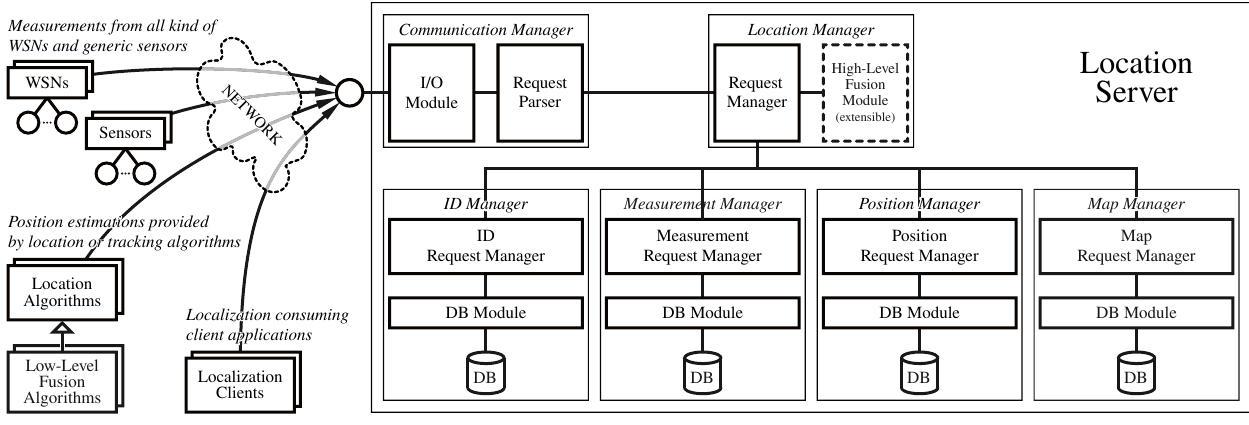
Figure 2. Proposed architecture for Hybrid Real-Time Location